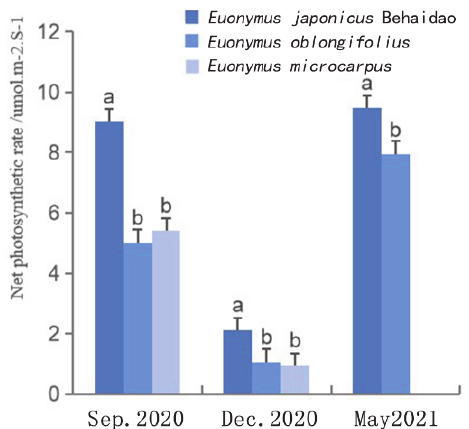
Figure 6. Changes of the net photosynthetic rate in three species; a and b represent significant